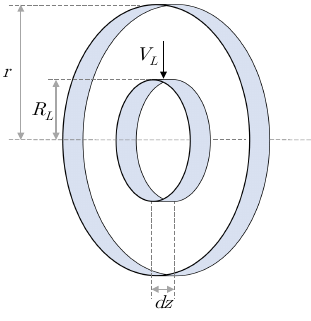
Figure 11. Visualization of radial area scaling of V L